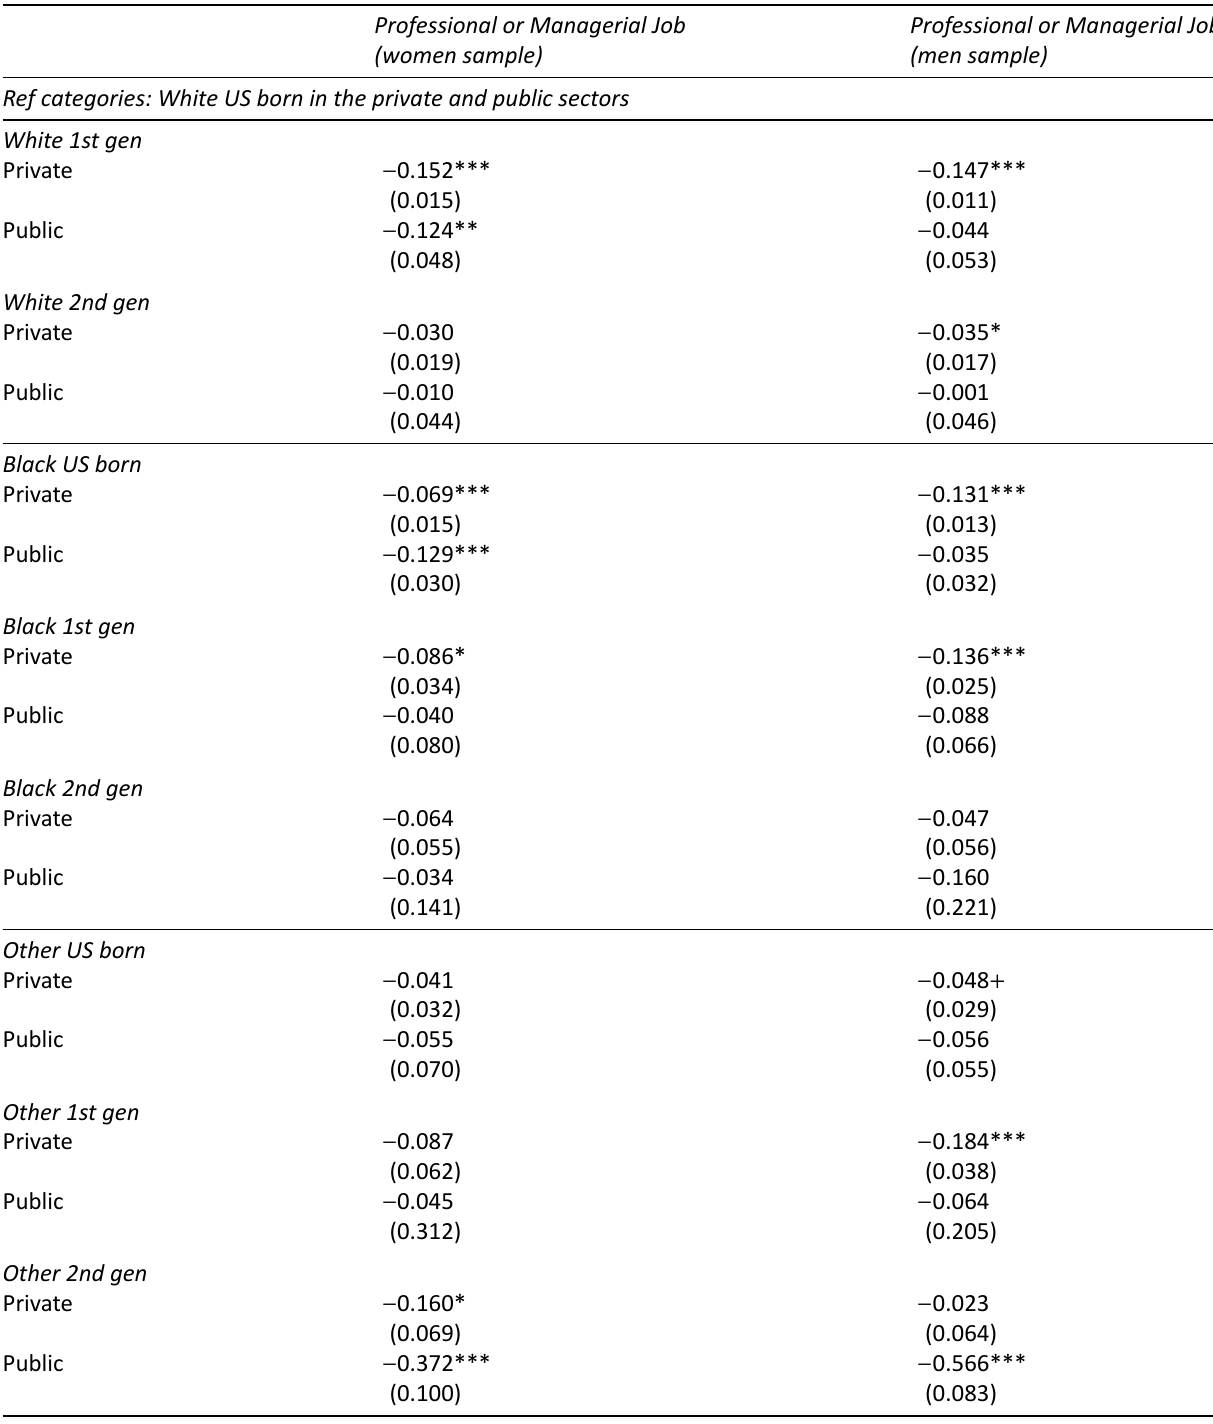
Table 4. Ethnic and migrant gaps in private and public sectors for professional or managerial jobs. Source: US Census Bu- reau